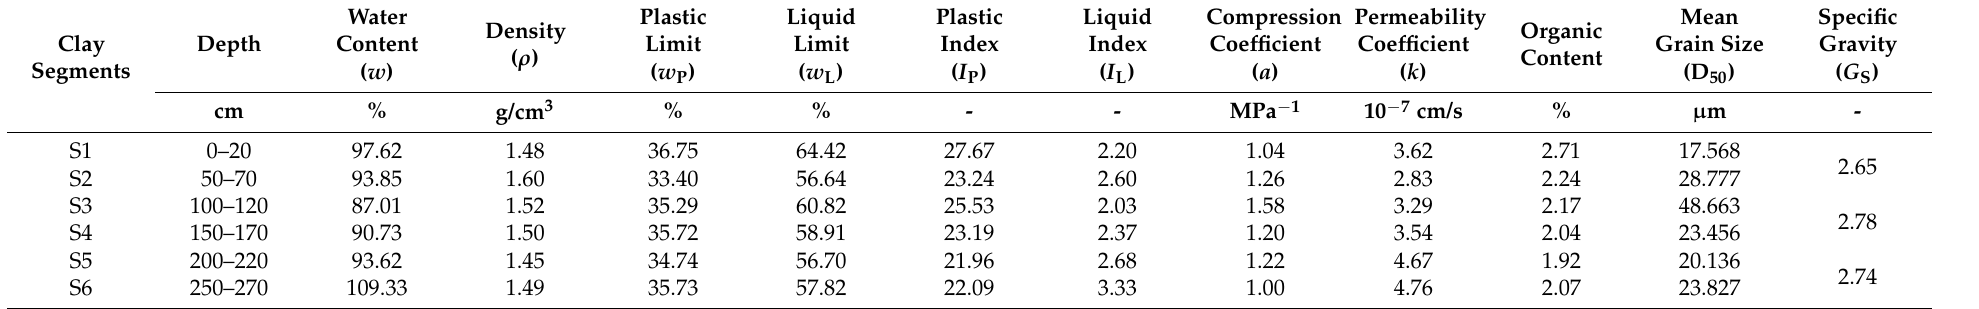
Table 1. Physical properties of the six sediment